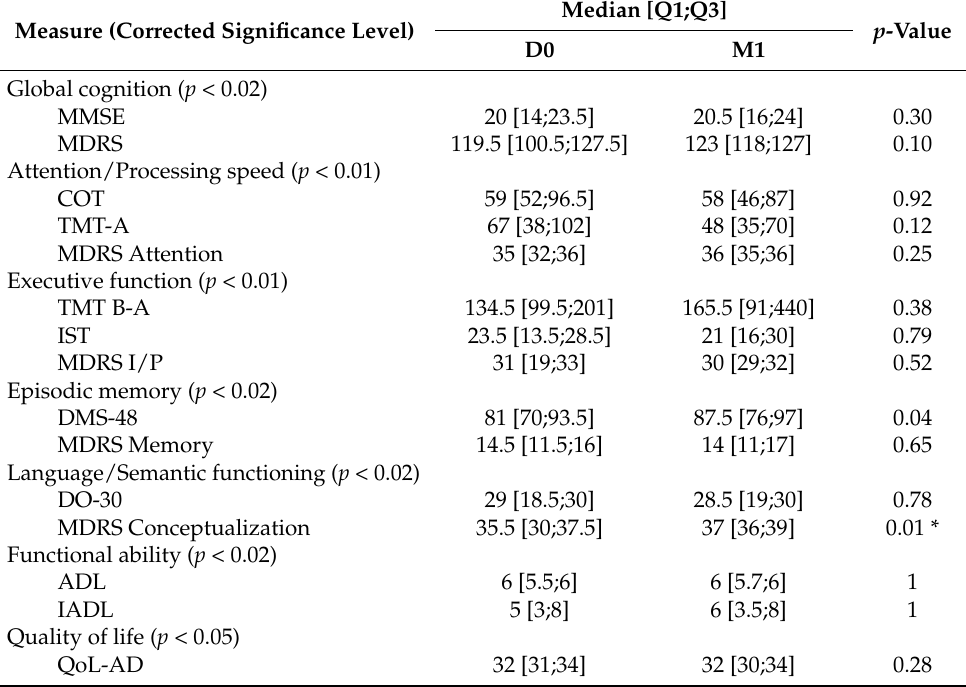
Table 3. Median values and quartiles [Q1;Q3] for pre- (D0) and 1-month post-10 rTMS sessions (M1) measures with p -values.